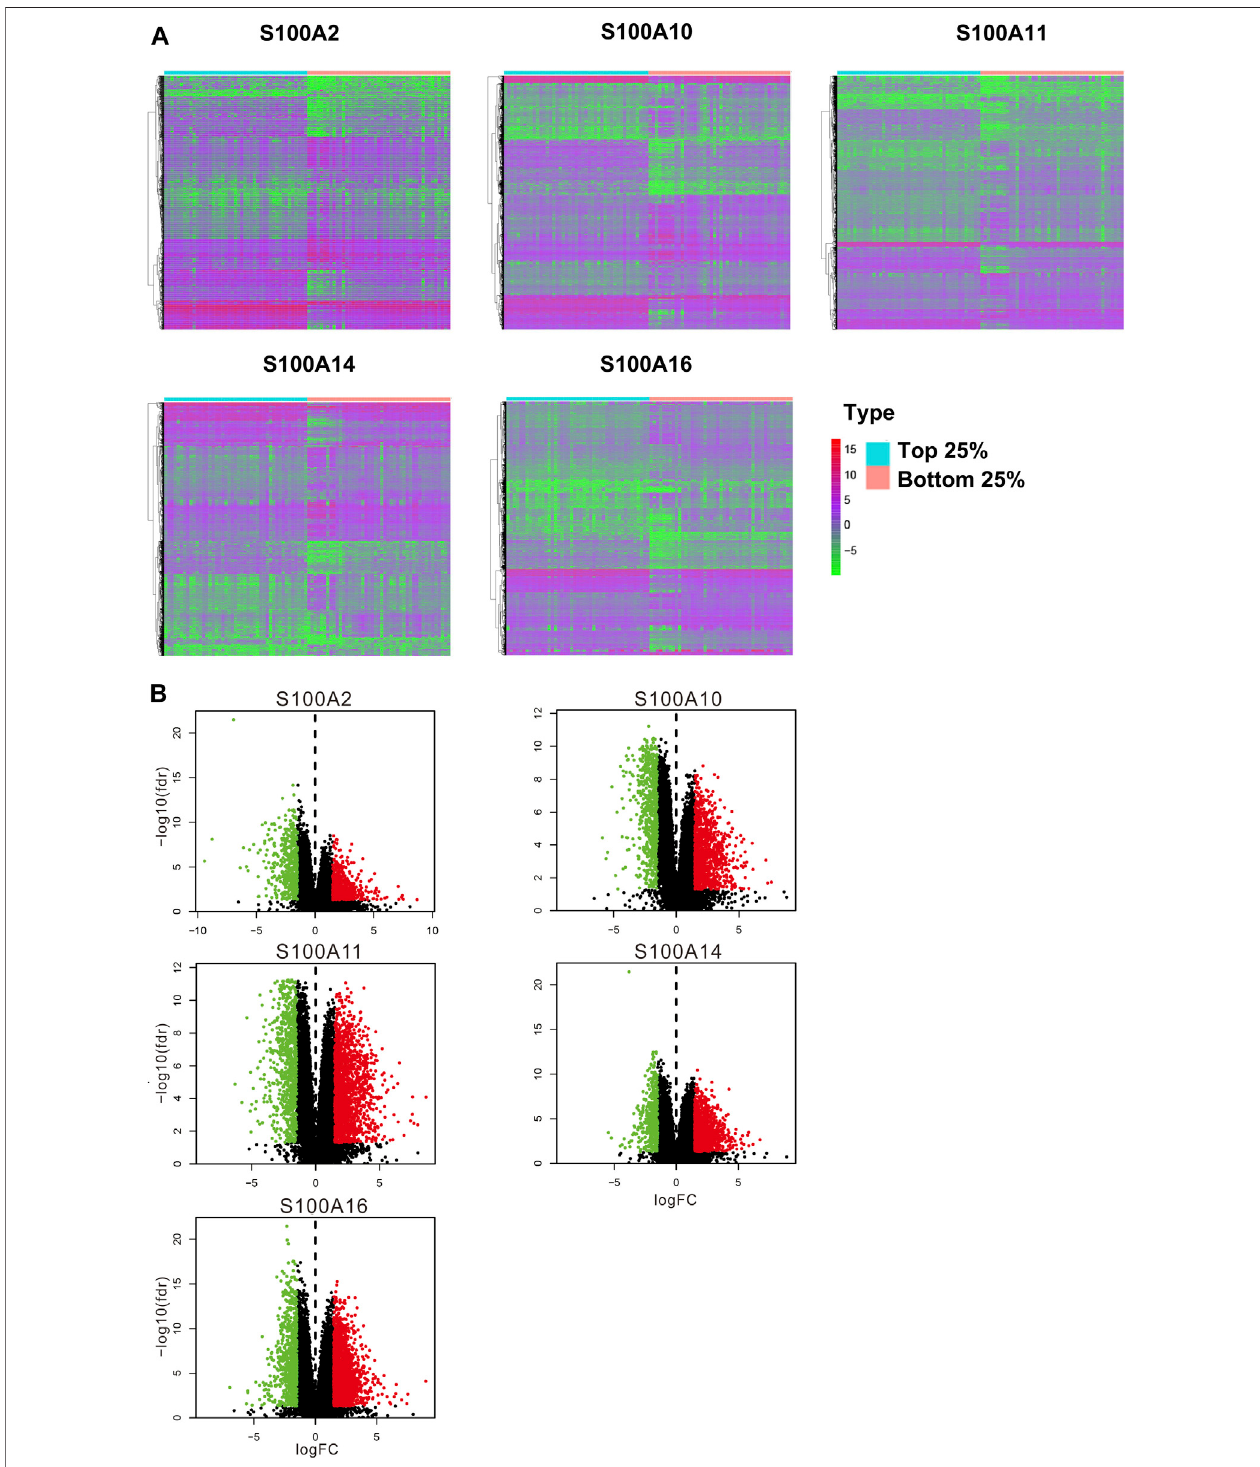
FIGURE 10 | Differential expression analysis of samples with high expression of the signi fi cant S100 genes (top 25%) vs low expression (bottom 25%) samples (calculated data form TCGA-PAAD database, n (cid:1) 178). (A) Differentially expressed genes were displayed by heatmap. Wilcox test was used to analyze differentially expressed genes. The screening conditions are FDR (cid:1) 0.05 and logFC (cid:1) 1.5. The green on the heatmap indicates low expression and red indicates high expression. (B) Volcano plot. The green dot on the volcano plot represents down-regulated expression, and the red dot represents up-regulated expression.